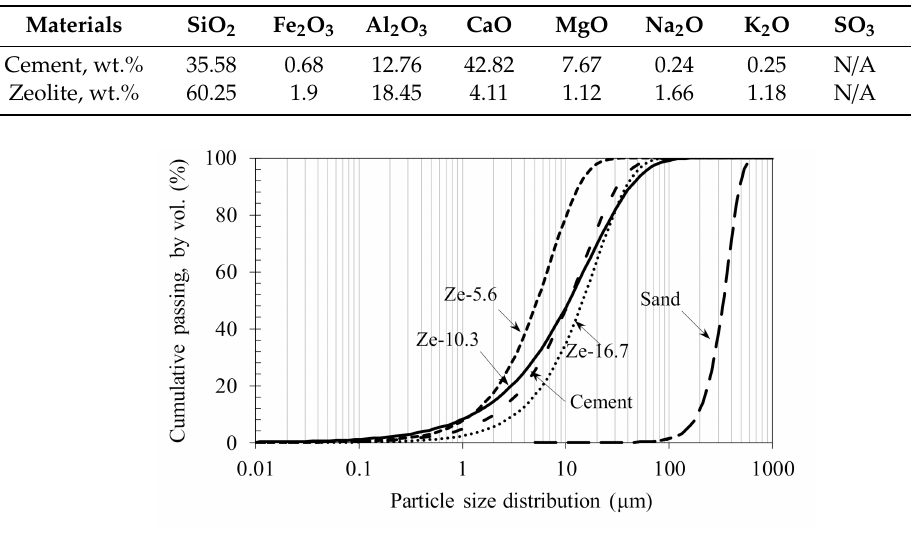
Figure 1. Particle size distribution of raw materials used in this study.